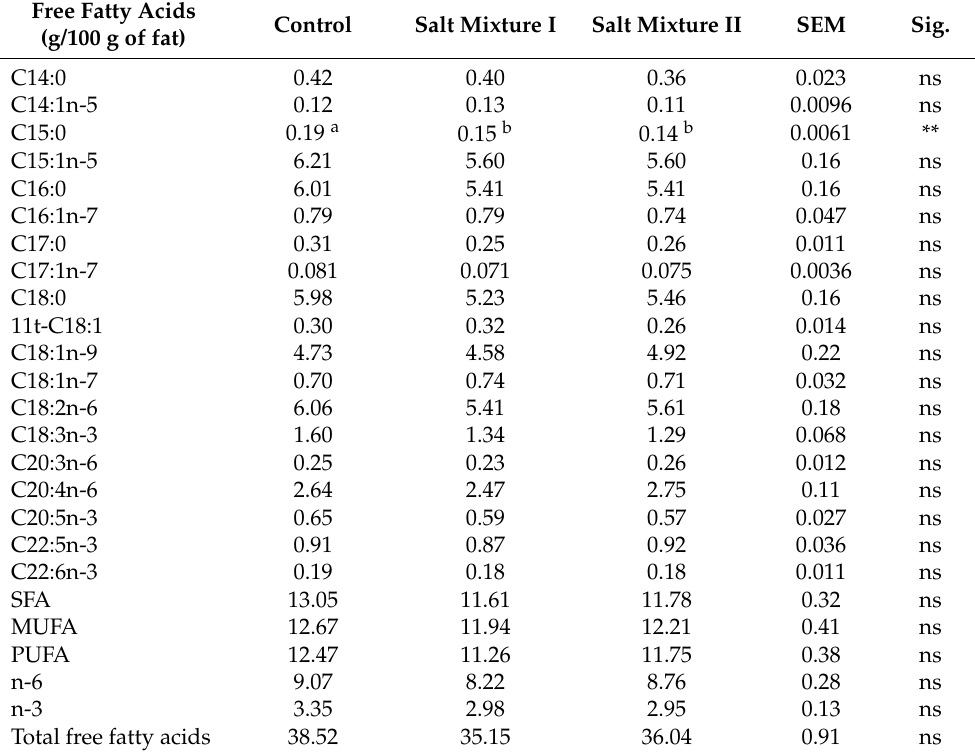
Table 3. Effect of NaCl replacement by other chloride salts on free fatty acids of dry-cured deer